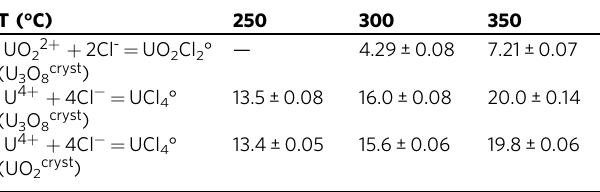
Table 2 Calculated formation constants (logß) for the uranium species identi fi ed in this